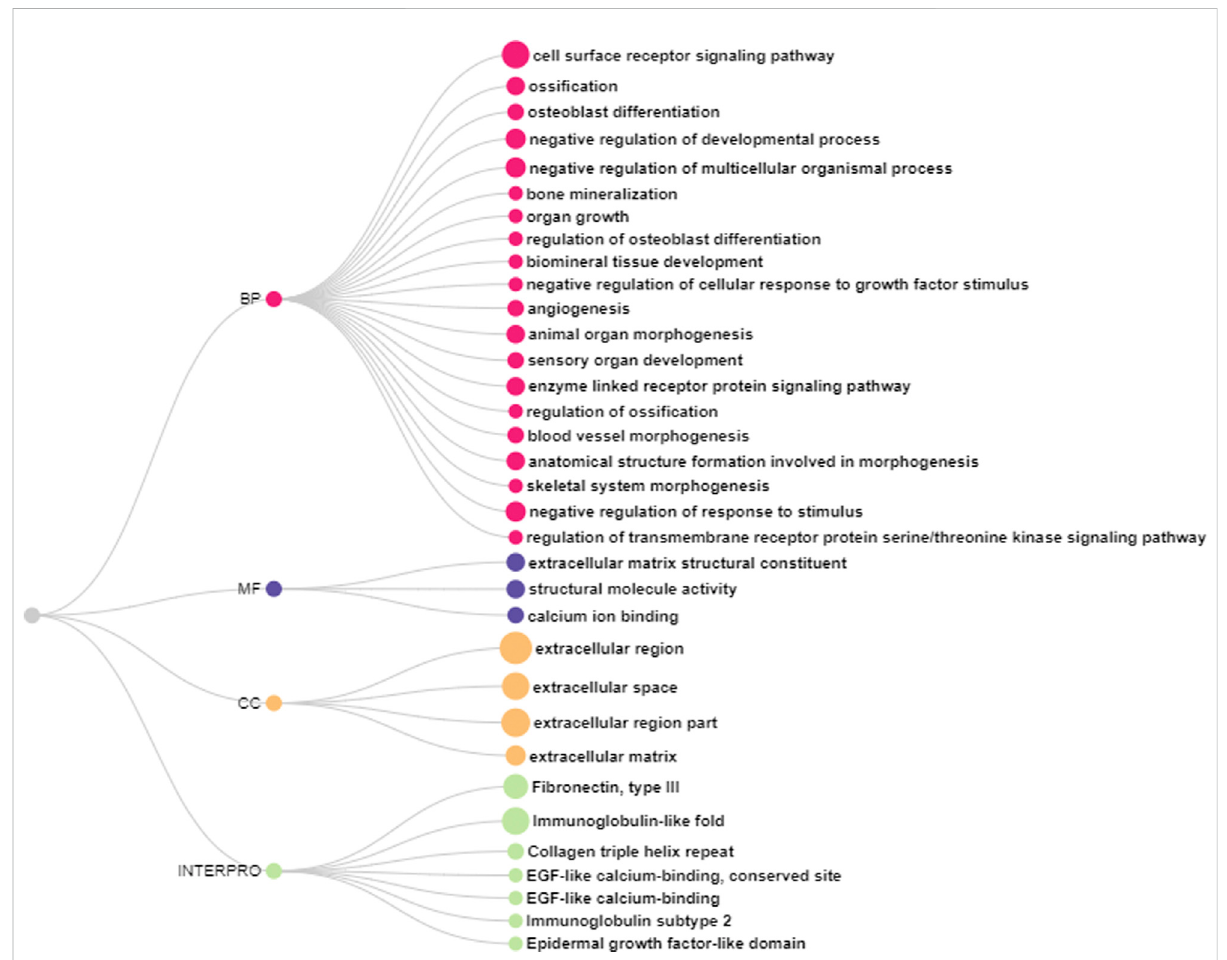
FIGURE 2 Biological processes (BP),molecularfunctions (MF),cell component (CC) andproteindomains according to theInterproenrichedusingDAVID